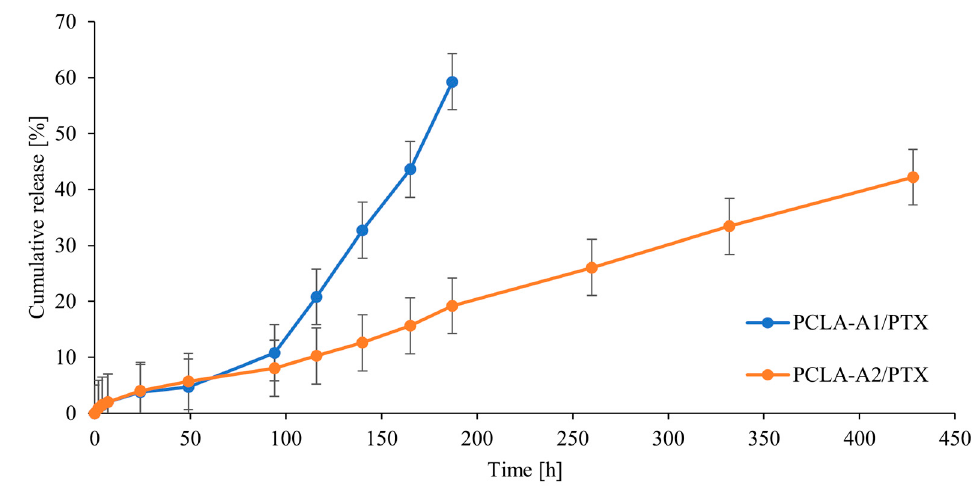
Figure 12. Drug release profiles of the PCLA-A1/PTX and PCLA-A2/PTX hydrogels. Table 8. The drug release profiles from the synthesized hydrogels, analyzed using mathematical models.